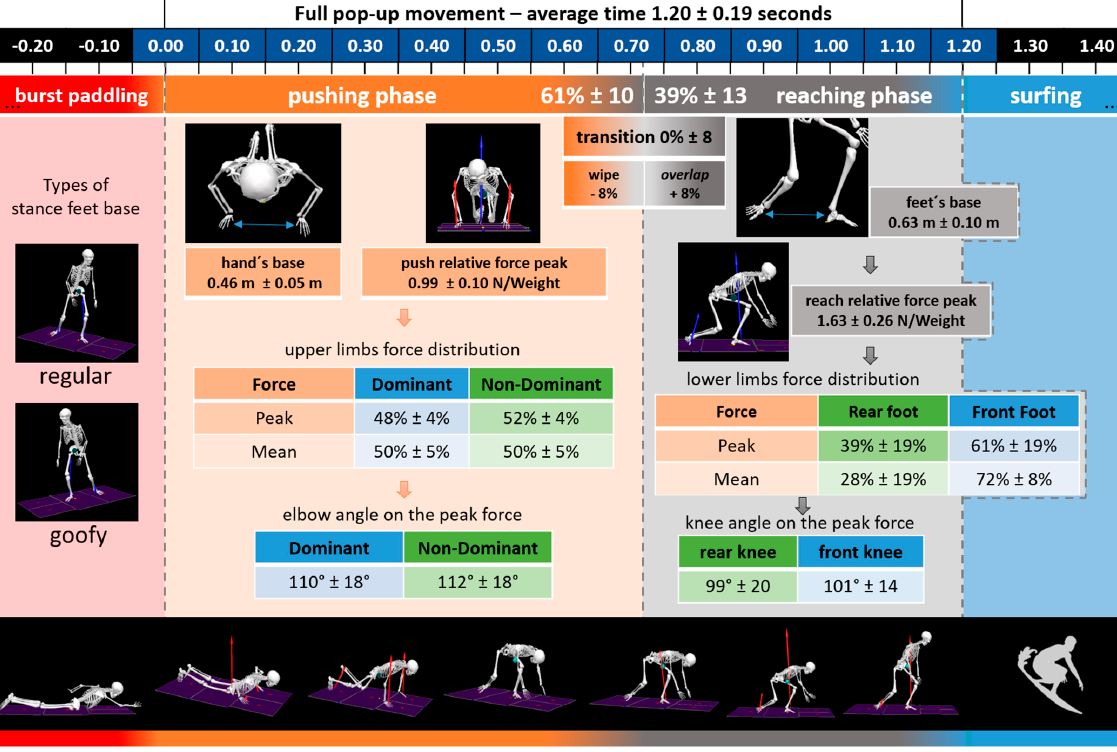
Figure 4. Infographic of pop-up movement results .